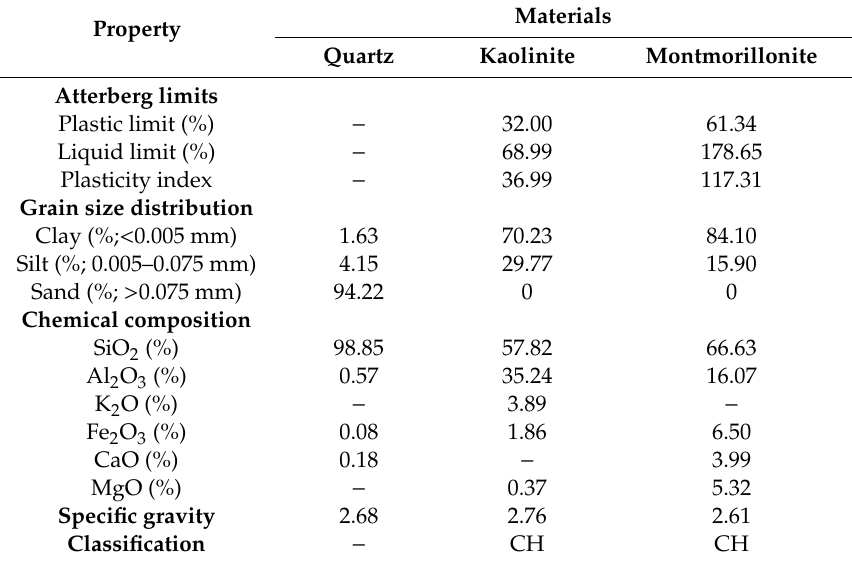
Table 1. Basic properties of quartz, kaolinite, and montmorillonite used in this study. Materials Property Quartz Kaolinite Montmorillonite Atterberg limits Plastic limit (%) − 32.00 61.34 Liquid limit (%) − 68.99 178.65 Plasticity index − 36.99 117.31 Grain size distribution Clay (%; < 0.005 mm) 1.63 70.23 84.10